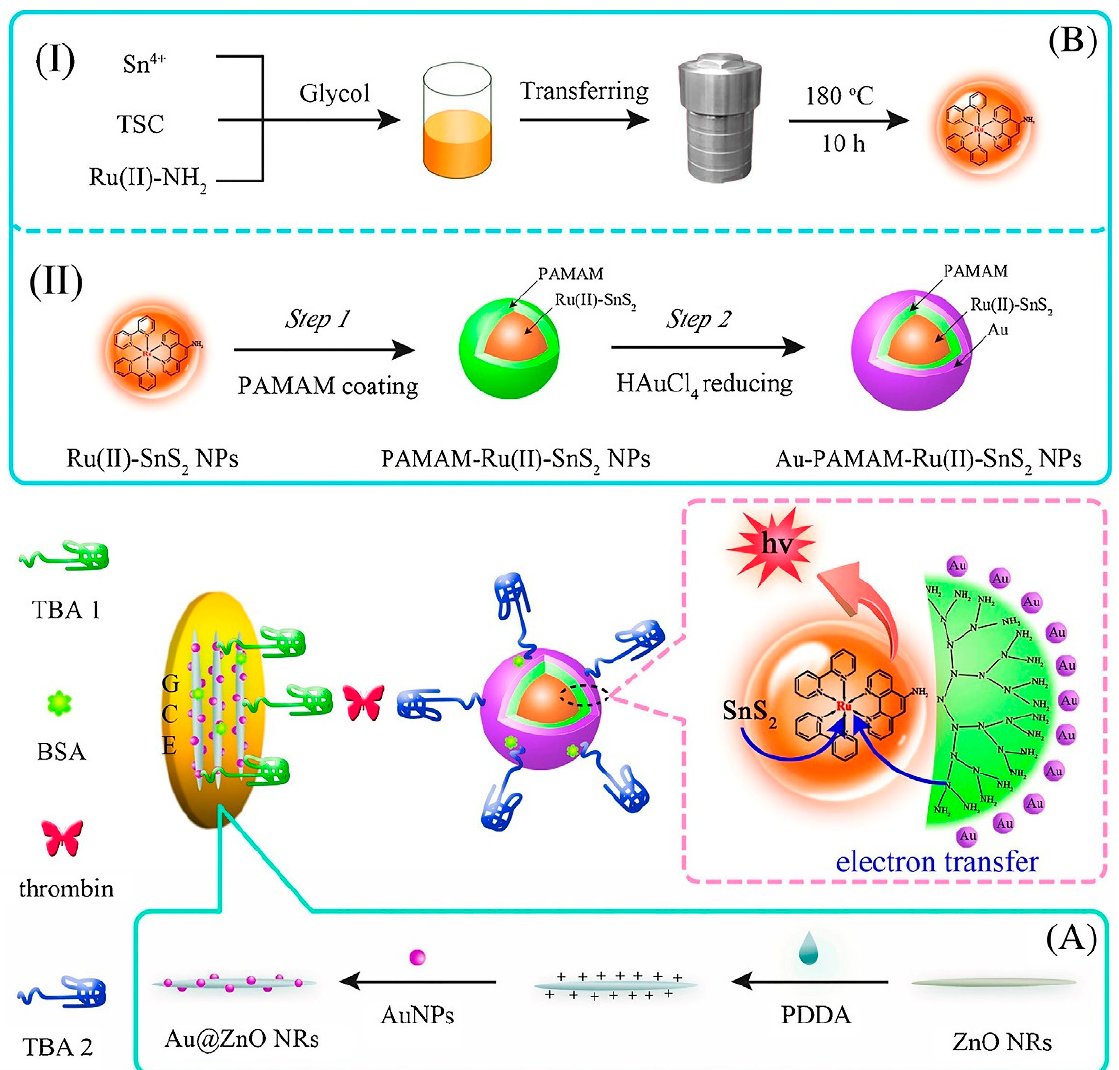
Figure 7. The electrochemiluminiscence-based aptamer for TB determination. The preparation process for TB sensing. ( A ) Schematic of the manufacturing of Au@ZnO NRs, and ( B ) self-enhanced tri-layer Au-PAMAM-Ru(II)-SnS2 nanoparticles’ gradual production process [121].